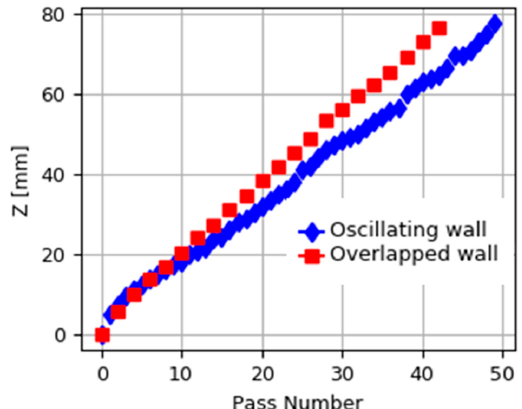
Figure 11. Wall height Z measured at layer growth evolution in both walls.